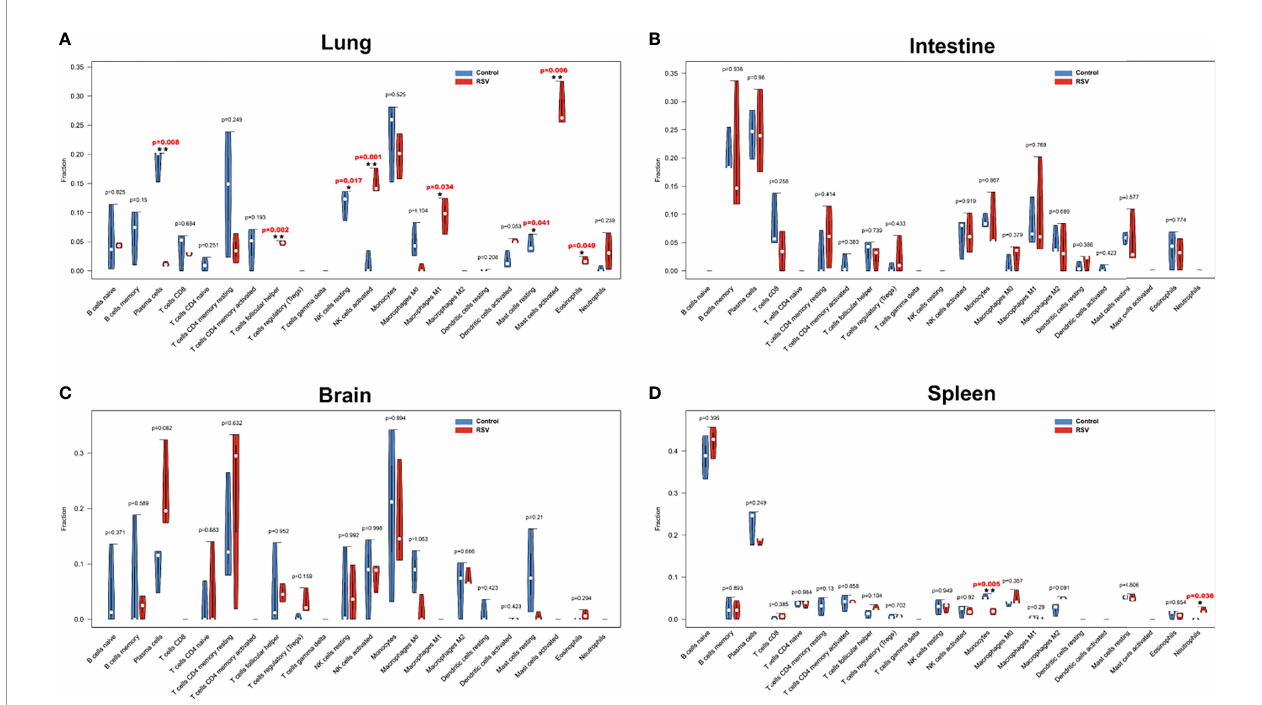
FIGURE 3 | Violin diagram of proportion of 22 types of immune cells in four organs. (A) Lung, (B) intestine, (C) brain, and (D) spleen showed differences in immune cell in fi ltration between RSV-infected and control mice at 12 h post-RSV infection. * p < 0.05, ** p < 0.01, compared with control group